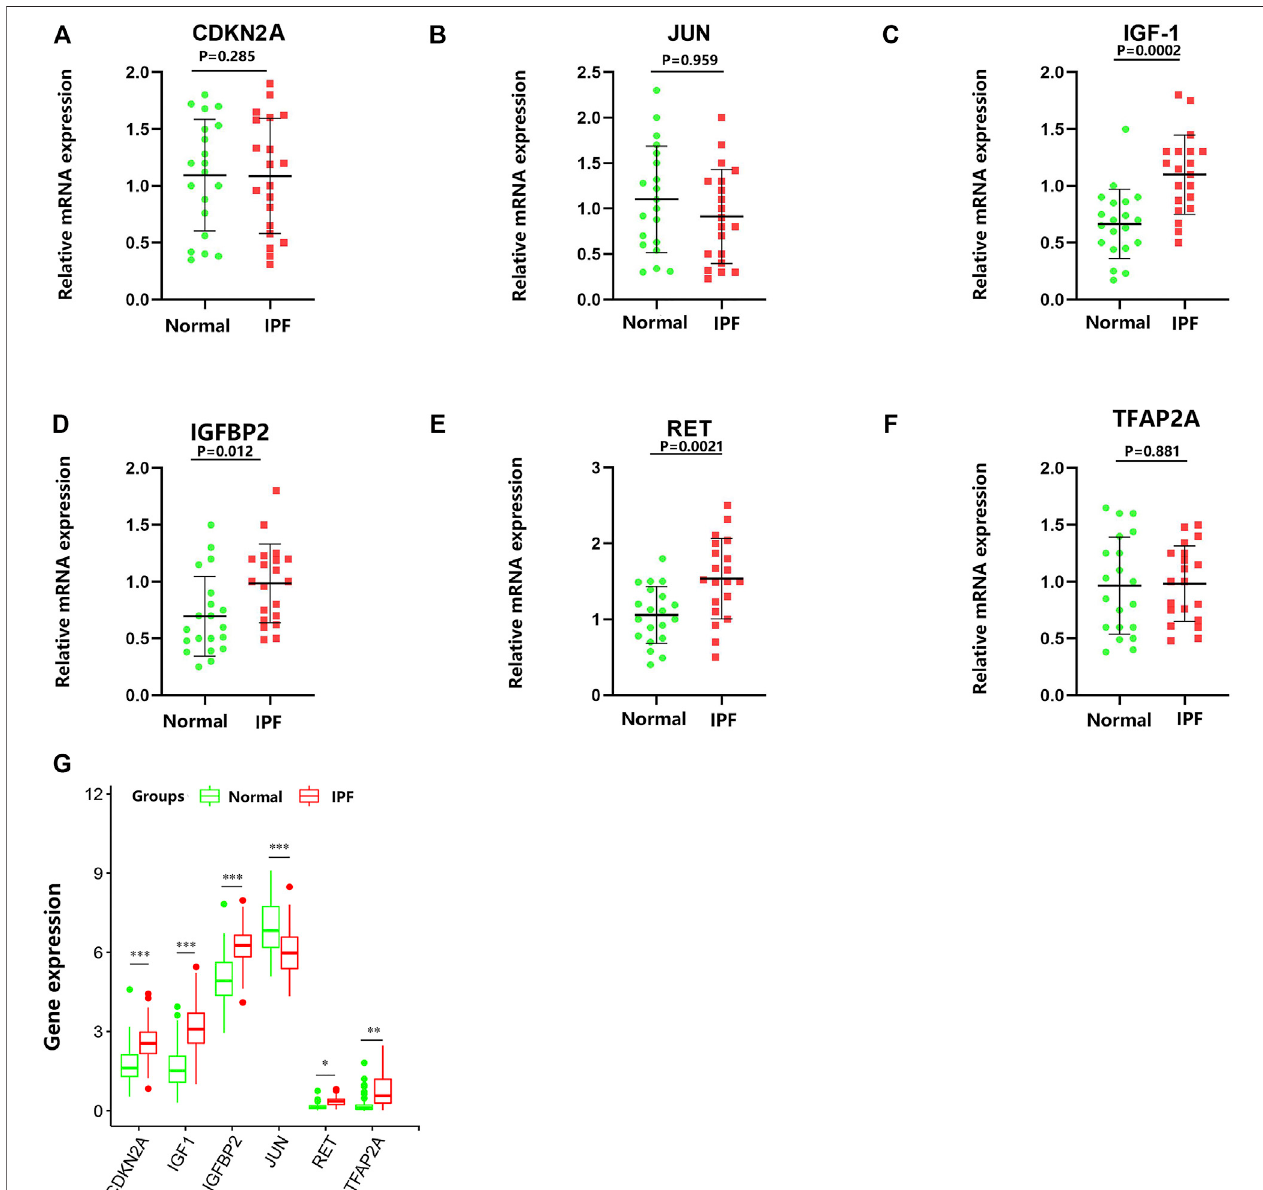
FIGURE 9 | RNA expression of six speci fi cally expressed aging-related genes were measured in IPF and healthy samples. p -values were calculated using a two- sided unpaired Student ’ s t-test. (A – F) Relative mRNA expression of the aging-related genes was analyzed by qRT-PCR. (G) The RNA-Seq expression of aging-related genes. * p < 0.05; ** p < 0.01; *** p <